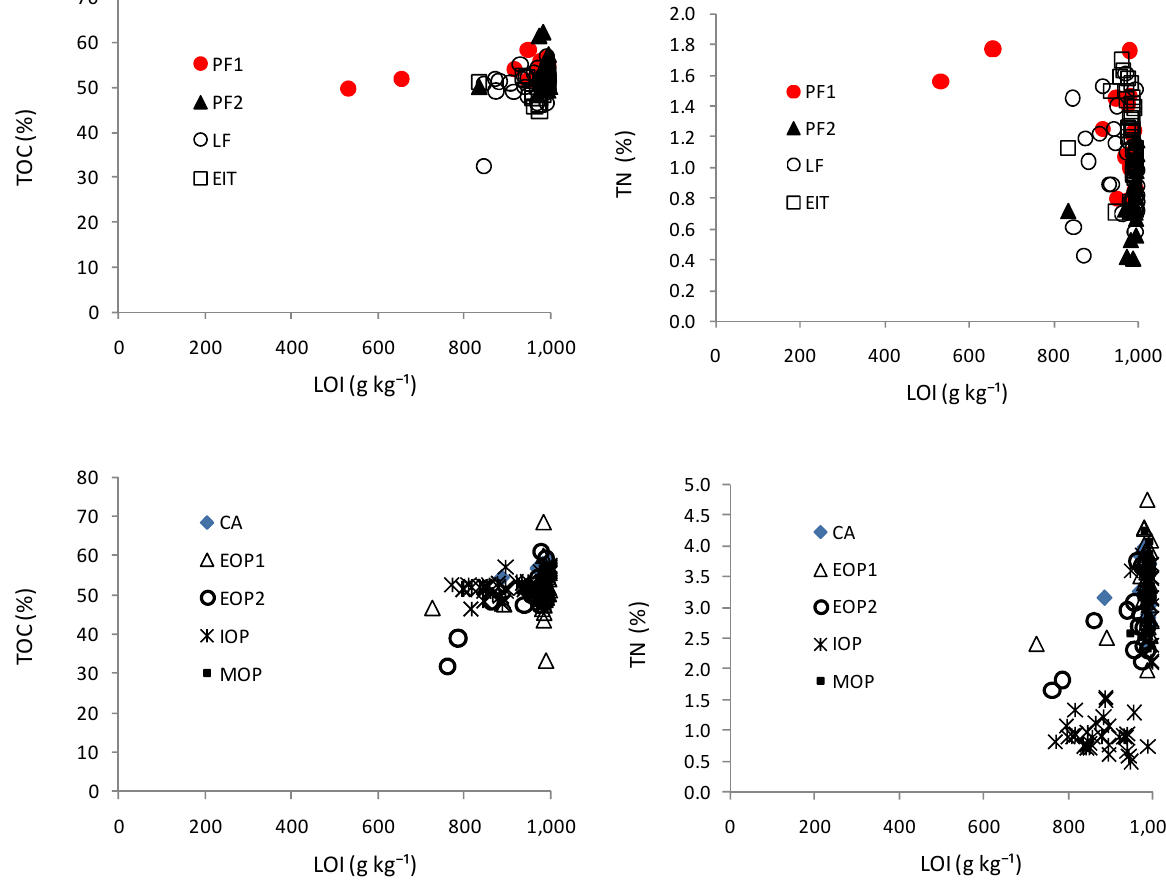
Fig. 6. Scatter plots LOI versus TOC and LOI versus TN according to Land Use Groups (PF1 = coastal peat forest; PF2 = inland peat forest; LF = logged over peat forest; EIT = industrial timber plantation; CA = community agriculture; EOP1 = Early Oil Palm ( < 5yrs) in coastal peat; EOP2 = Early Oil Palm ( < 5yrs) in inland peat; IOP = Intermiediate Oil Palm (5–10yrs); MOP = Mature Oil Palm (15-20 yrs) Figure 7. A scatted plot LOI vs TOC in the upper 200 cm depth from Sebangau Peat Forest, Central Kalimantan (Modified from Page et al., 2004)